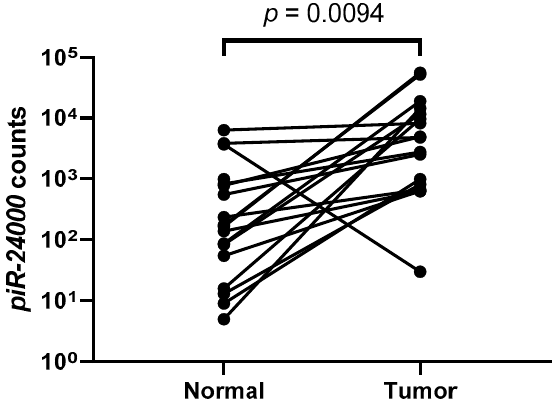
Figure 2. Expression of piR-24000 in the discovery cohort. Expression levels (counts) of piR-24000 in tumor samples compared with the adjacent non-malignant colon tissue.